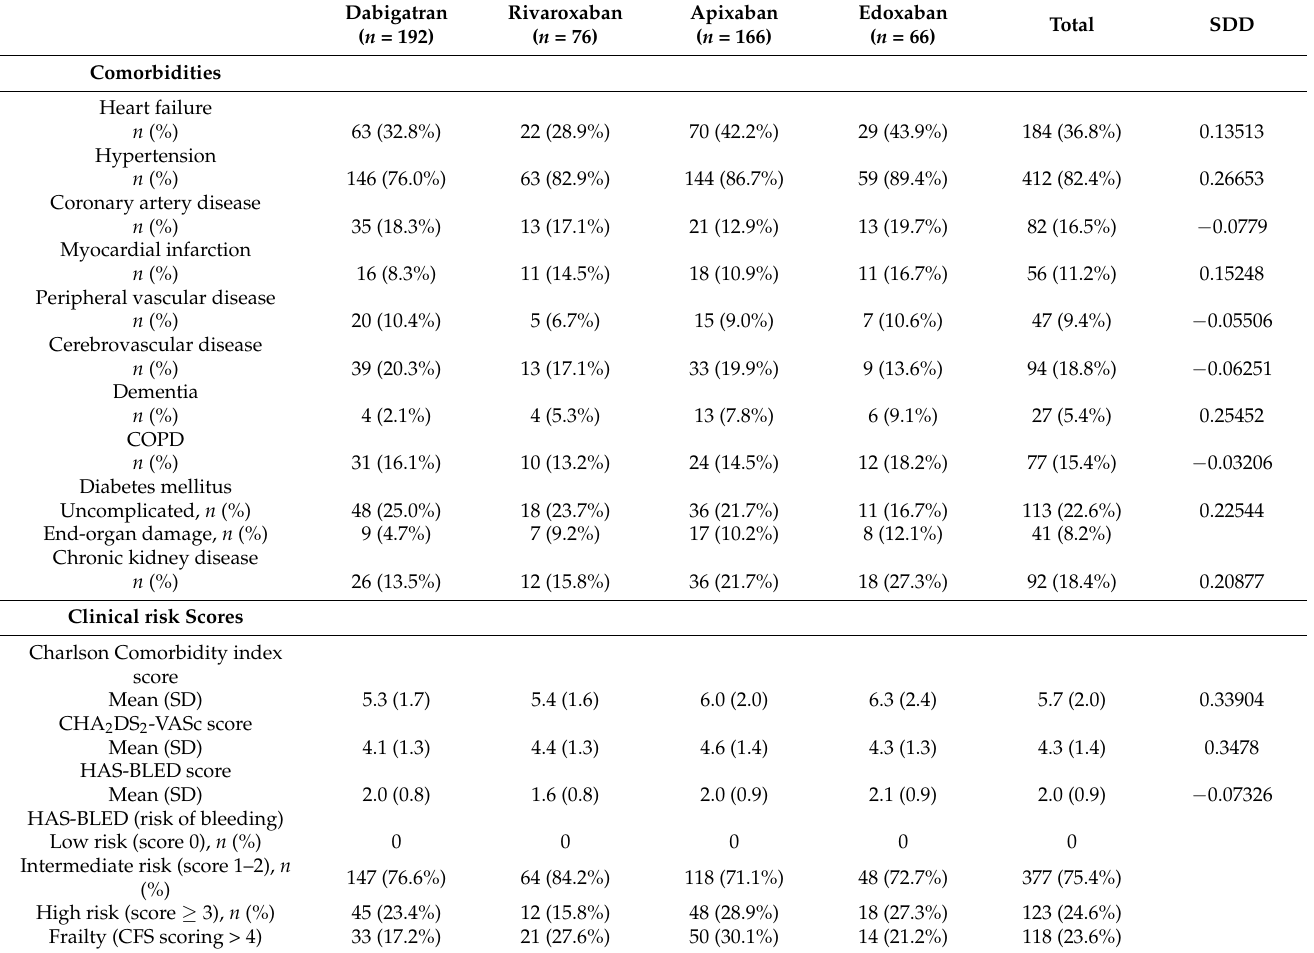
Table 2. Distribution of comorbidities and clinical scores according to NOAC